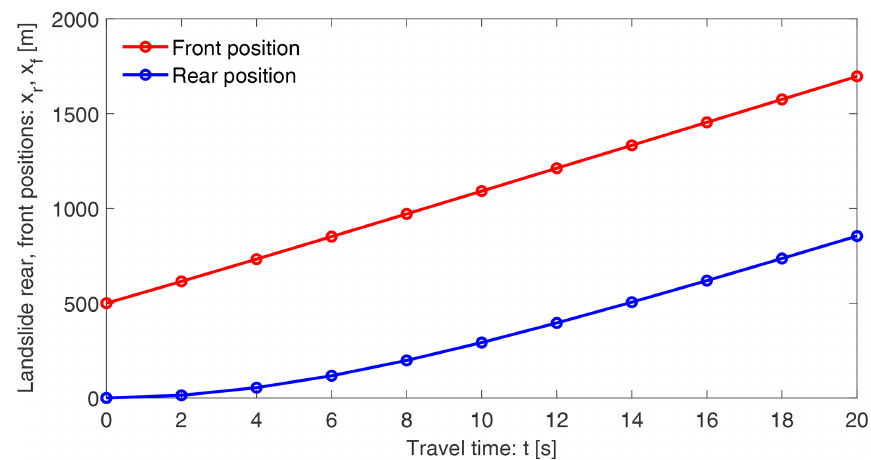
Figure 10. Time evolution of the front and rear positions of the landslide as it moves down the slope including the internal deformation given by the general solution in Eqs. (39) and (40) of Eq. (5), corresponding to the initial condition s 0 ( x ) = x 0 . 65 in Fig. 9.